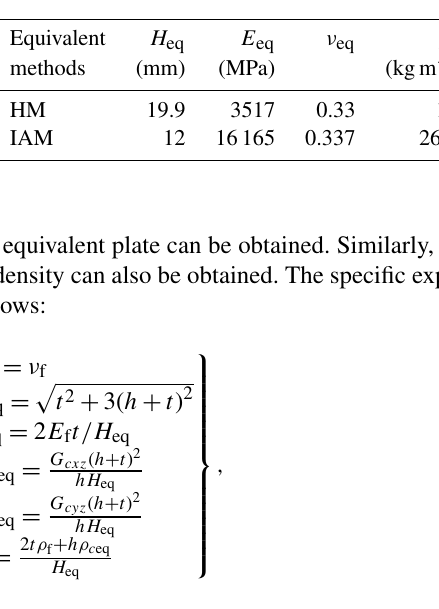
Table 2. Equivalent material parameters of the single-layer plate equivalent method based on the Hoff (1948) theory (HM) and the improved Allen (1969) equivalent method